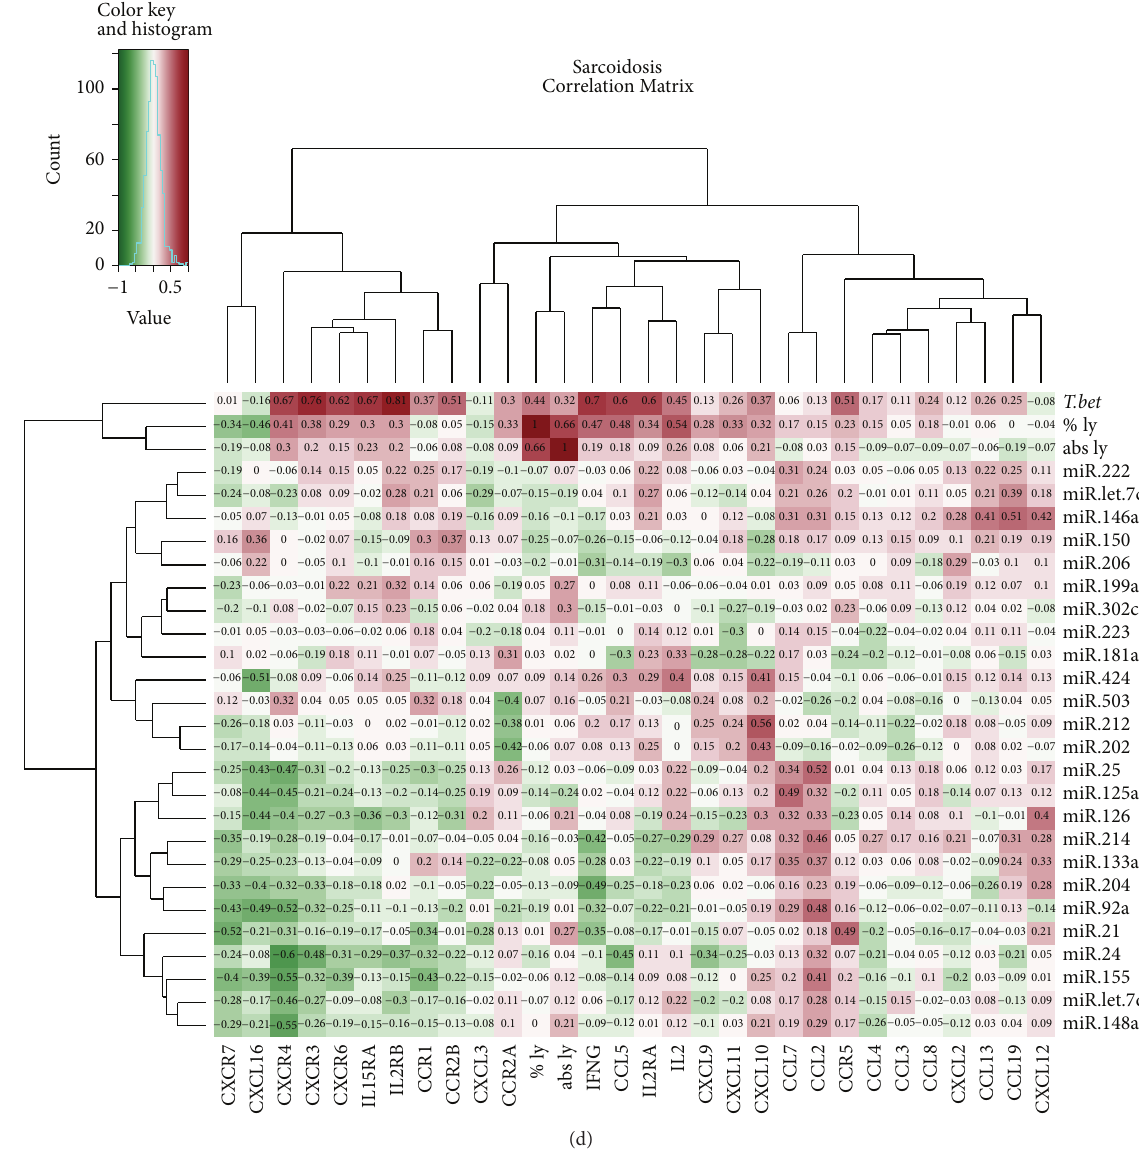
Figure 4: miRNA-mRNA- T-bet correlations in BAL cells obtained from (a) sarcoidosis patients and their subgroups with (b) progressing and (c) regressing disease are represented using Chord diagrams (circular graphs). In the Chord diagram, the intensity of the band corresponds to the significance of the correlation between particular miRNA-mRNA pair and T-bet -mRNA pair as assessed using Spearman’s rank correlation; only significant correlations ( 𝑃 < 0.05 ) are visualized. (d) A hierarchical agglomerative clustering analysis presented using heat map for sarcoidosis as a whole. The colour of each cell of the heat map corresponds to value of Spearman correlation coefficient between given miRNA-mRNA pairs. % ly: % of lymphocytes in BAL fluid; abs ly: absolute number of lymphocytes/1 mL BAL